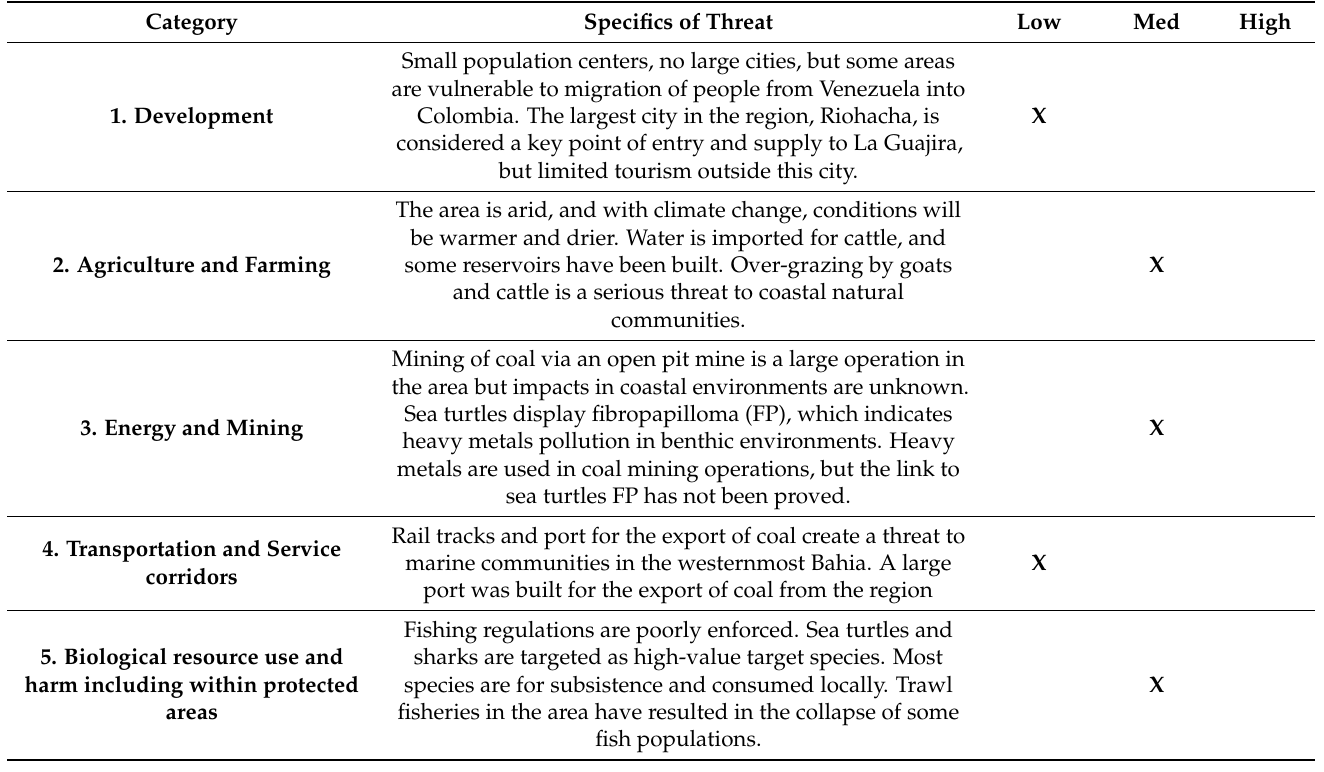
Table 3. Threats to the coastal biological diversity of the Guajira peninsula from El Cabo to the Venezuela border. This represents about 370 km of shoreline, including embayments. The coastal marine ecosystems include coastal mangrove wetlands, seagrass meadows, soft bottom communities, and algal beds.